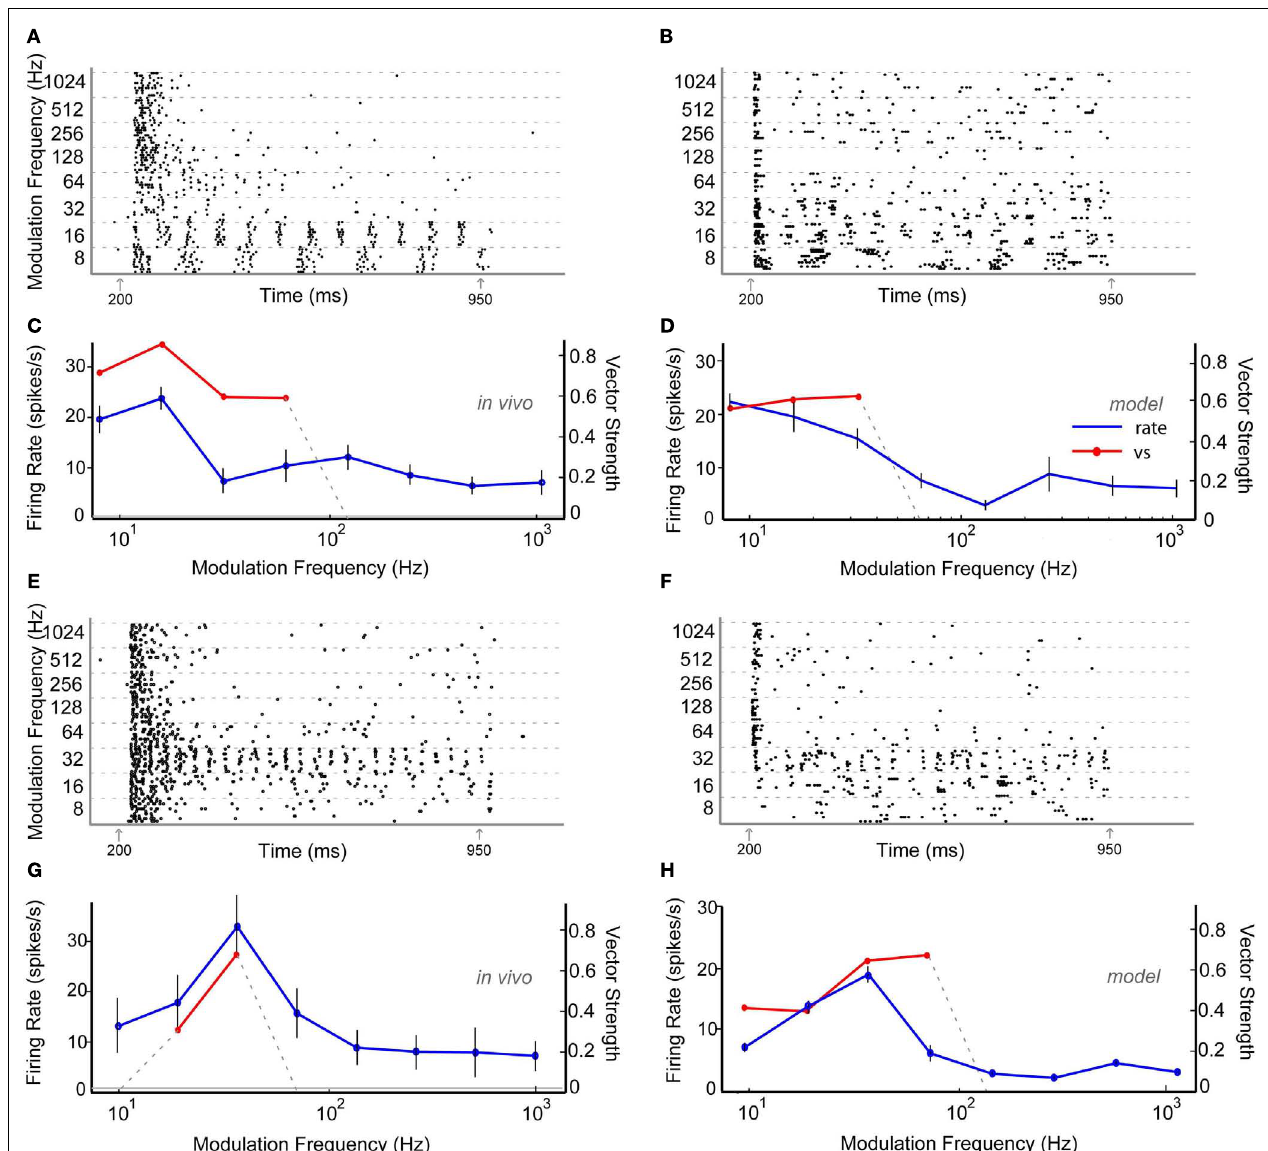
gray line indicates mean spontaneous firing rate. Error bars indicate 1 standard deviation from mean firing rate. (D) Adapting IC model neuron using inputs described in (B) showing mean firing rate (blue) of 10 trials, and significant vector strength (red). Axes similar to (C) . (E) Dot-raster plot of responses of unitY30 from the IC of a young animal to nAM stimuli presented at 75dB SPL. (F) Dot-raster plot of a Sustained model neuron using three user-defined low-pass excitatory inputs with six low-pass inhibitory inputs, each with corner frequencies at 32Hz. (G) Mean firing rate and vector strength of neuron shown in (E) for various modulation frequencies, exhibiting band-pass rMTF and tMTF. Axes similar to (C) . (H) Mean firing rate and vector strength of model neuron described in (F) for various modulation frequencies, showing mean firing rate (blue) of 10 trials, and significant vector strength (red). Axes similar to (G)